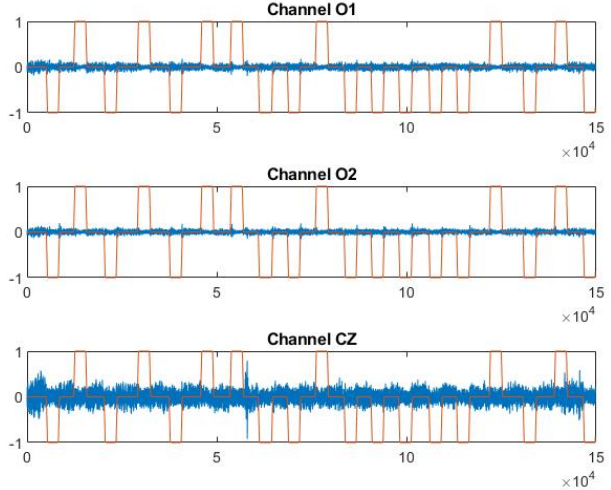
Figure 4. Trend of channels O1, O2, and CZ vs. the output signal (cid:1877) in file P4 F1.